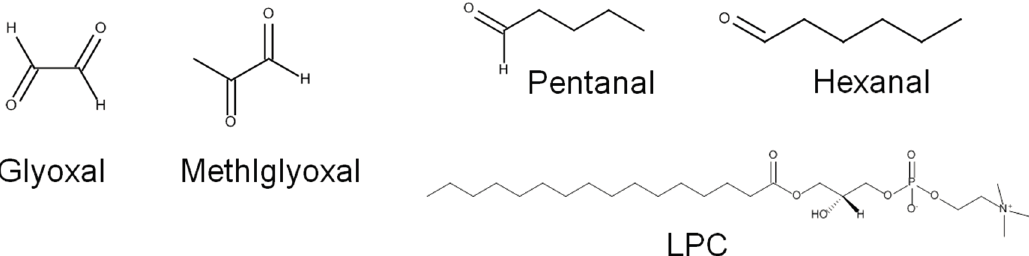
Figure 7. α -Oxoaldehydes, alkanals, and